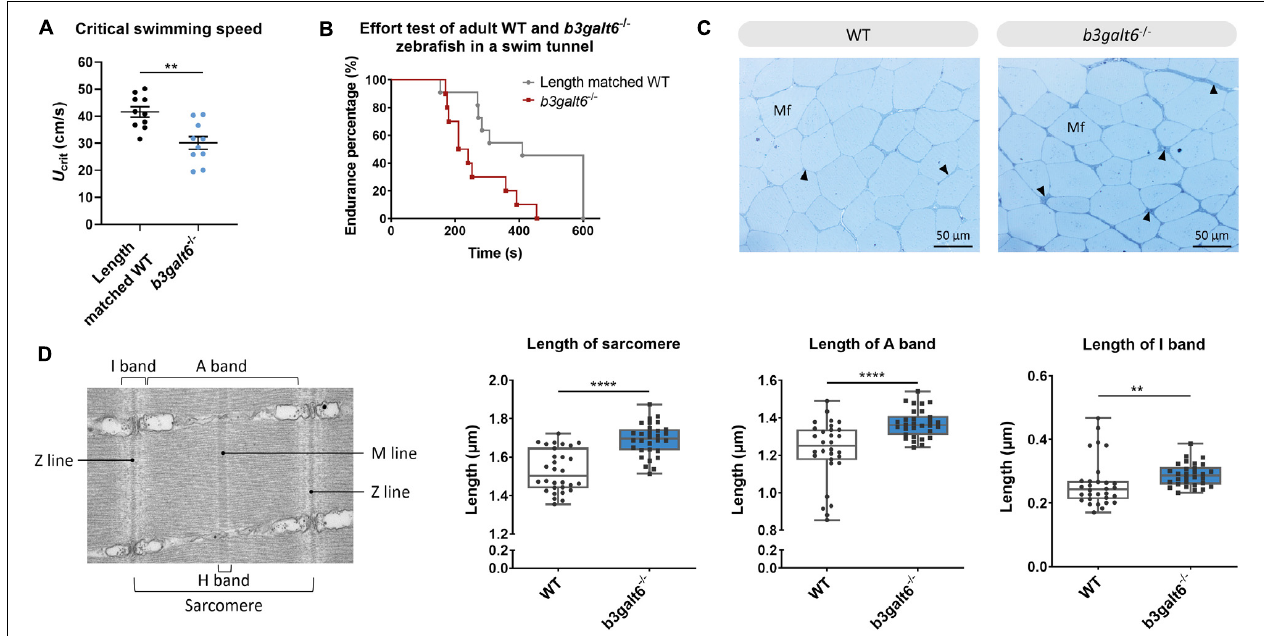
FIGURE 8 | Functional and structural analysis of adult WT and b3galt6 − / − zebrafish muscle. (A) The critical swimming speed and (B) the endurance performance was determined for b3galt6 − / − and length-matched WT zebrafish. (C) Semi-thin cross sections, stained with toluidine blue, demonstrate the presence of a thicker endomysium (arrowhead), located between the muscle fibers (Mf) at the horizontal myoseptum of b3galt6 − / − zebrafish at the age of 5 months. (D) Transmission electron microscope structure of a sarcomere with indications of the Z and M line and A, I, and H band. The sarcomere length was determined at 5 different loci per semi-thin section, for 6 semi-thin sections origination from 3 different zebrafish per genotype ( N = 30). A significant increase in sarcomere length for b3galt6 − / − is noted. Furthermore, both the A and I band show an increase in length for the mutant zebrafish. Data are expressed as box plots with min-to-max whiskers on which each individual data point is plotted. A Mann-Whitney U test was used to determine significance. **** P < 0.0001, ** P <